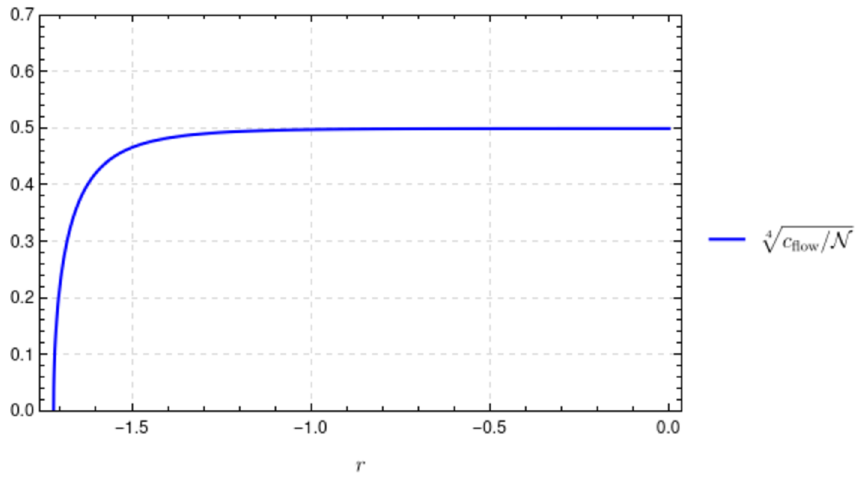
Figure 5 . Plot of the flow central charge for the non-SUSY solution discussed in section 5.5. We have chosen G = 1 . The monotonicity of this quantity is clearly N